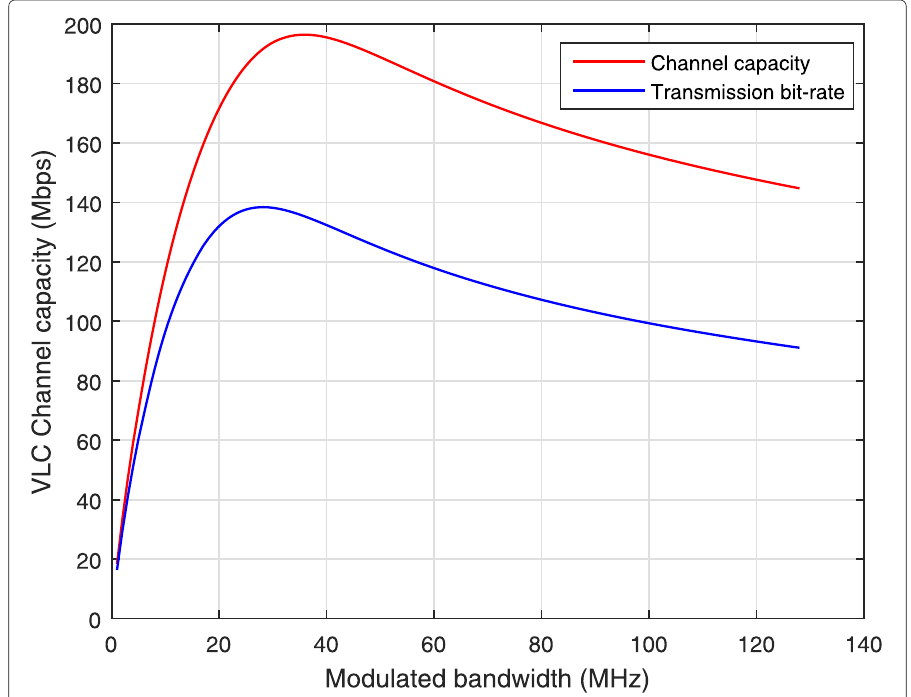
Fig. 9 System transmission bit rate with different bandwidths. The capacities and the transmission bit rates for a bit error rate of 10 − 3 according to the modulated bandwidth